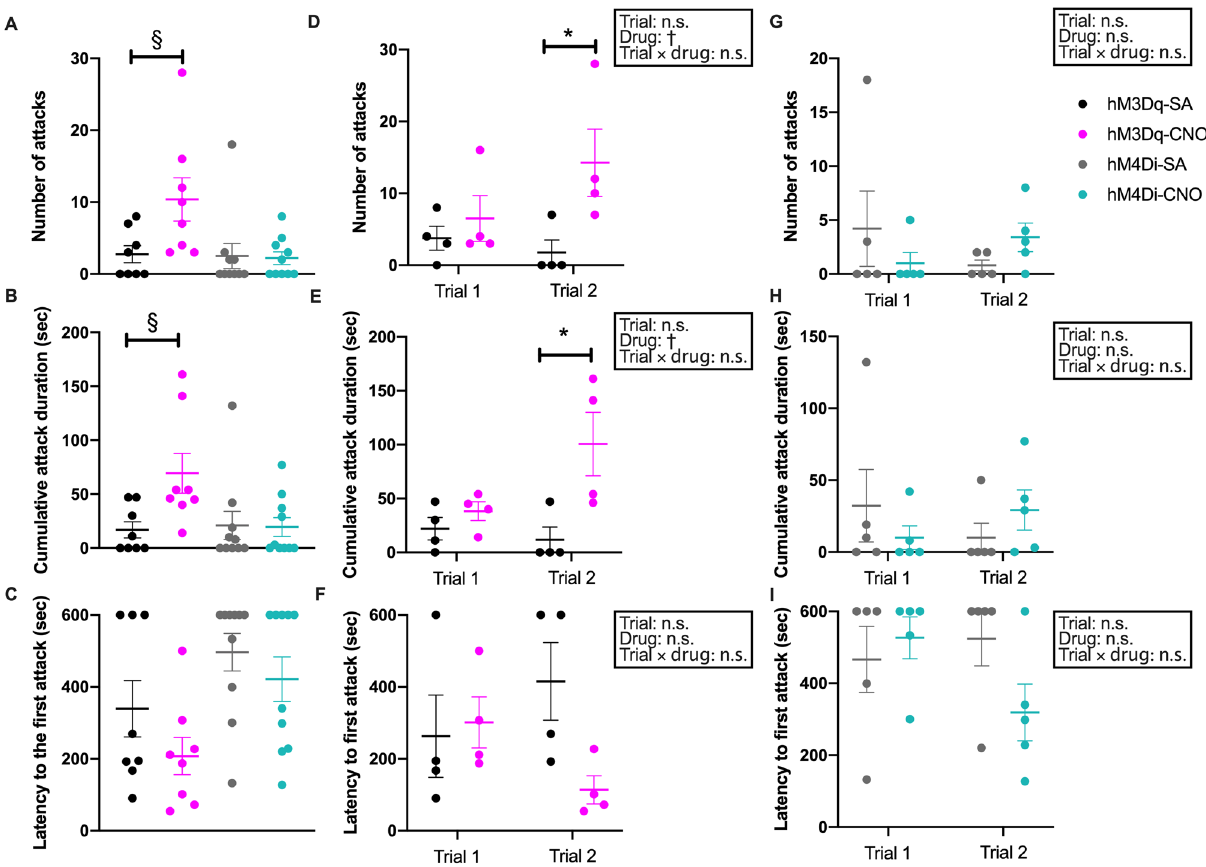
Figure 3. Chemogenetic activation of HA TMN neurons enhanced aggression in the resident ‒ intruder test. The parameters of aggressive behaviours were compared b Hdc-hM3Dq mice ( A , B , D , E , G and H ) and Hdc- hM4Di mice ( A , C , D , F , G and I ) for 10 min after CNO or SA injection. ( A , D , G ) The combined results of trials 1 and 2, compared by Mann–Whitney U test (n = 8 or 10). ( B , E , H ) (n = 4), or ( C , F , I ) (n = 5) indicate results from each trial in Hdc-hM3Dq or Hdc-hM4Di mice, respectively. The results were compared by two-way RM ANOVA with main factors trial number (1 or 2) and drug treatment (CNO of SA), followed by Sidak’s post hoc tests. ( A ) Total number of aggressive behaviours ( P = 0.027 by Mann–Whitney U test). ( B ) Total cumulative duration of aggressive behaviours ( P = 0.013 by Mann–Whitney U test). ( C ) Total latency to first aggressive behaviour (no significant differences by Mann–Whitney U test). ( D ) Number of aggressive behaviours of Hdc- hM3Dq mice after CNO or SA injection in each trial (trial: F = 0.74, P = 0.42; drug: F = 7.51, P = 0.034; trial × drug interaction: F = 2.12, P = 0.20). ( E ) Cumulative duration of aggressive behaviours of Hdc-hM3Dq mice after CNO or SA injection in each trial (trial: F = 1.58, P = 0.26; drug: F = 16.68, P = 0.0065; interaction: F = 3.06, P = 0.13). ( F ) Latency to first aggressive behaviour of Hdc-hM3Dq mice after CNO or SA injection in each trial (n = 4; trial: F = 0.028, P = 0.87; drug: F = 3.89, P = 0.096; interaction: F = 2.58, P = 0.16). ( G ) Number of aggressive behaviours of Hdc-hM4Di mice after CNO or SA injection in each trial (trial: F = 0.059, P = 0.81; drug: F = 0.027, P = 0.87; interaction: F = 2.00, P = 0.12). ( H ) Cumulative duration of aggressive behaviours of Hdc-hM4Di mice after CNO or SA injection in each trial (trial: F = 0.0079, P = 0.93; drug: F = 0.011, P = 0.92; interaction: F = 1.50, P = 0.26). ( I ) Latency to first aggressive behaviour of Hdc-hM4Di mice after CNO or SA injection in each trial (n = 5; trial: F = 0.78, P = 0.40; drug: F = 1.12, P = 0.32; interaction: F = 2.44, P = 0.16). Data are presented as mean ± S.E.M. (horizontal bars and error bars) with superimposed individual data points (closed circles). † P < 0.05 by two-way RM ANOVA with main factors ‘time’ and ‘drug’, * P < 0.05 by post hoc Sidak’s multiple comparisons test. § P < 0.05. by Mann–Whitney U and decreased NREM sleep time within the first 1 h (ZT3 ‒ 4) while REM sleep time was not changed (Fig. 4B). We also found that wake bouts were significantly skewed toward longer duration in the hM3Dq-CNO group by cumulative probability analyses (Fig. 4E left panel), while the number and mean duration of waking, NREM sleep and REM sleep episodes during the first 1 h were not changed (Fig. 4C,D, and Table S1). CNO administra- tion to AAV-hM3Dq mice at ZT3 did not alter the frequencies of vigilance state transitions (Fig. 4F). On the other hand, the latency to first NREM sleep episode was significantly extended by hM3Dq-CNO (Fig. 4G). These results indicate that the activation of HA TMN neurons contributes to arousal maintenance but not to vigilance state transitions. There were no differences in EEG power spectra during wakefulness, NREM sleep and REM sleep between CNO and SA groups (Fig. S4A). In addition, CNO injection at ZT12 did not alter sleep–wake state in sub-analyses (Figs. S2 and S4B, and Table S1).